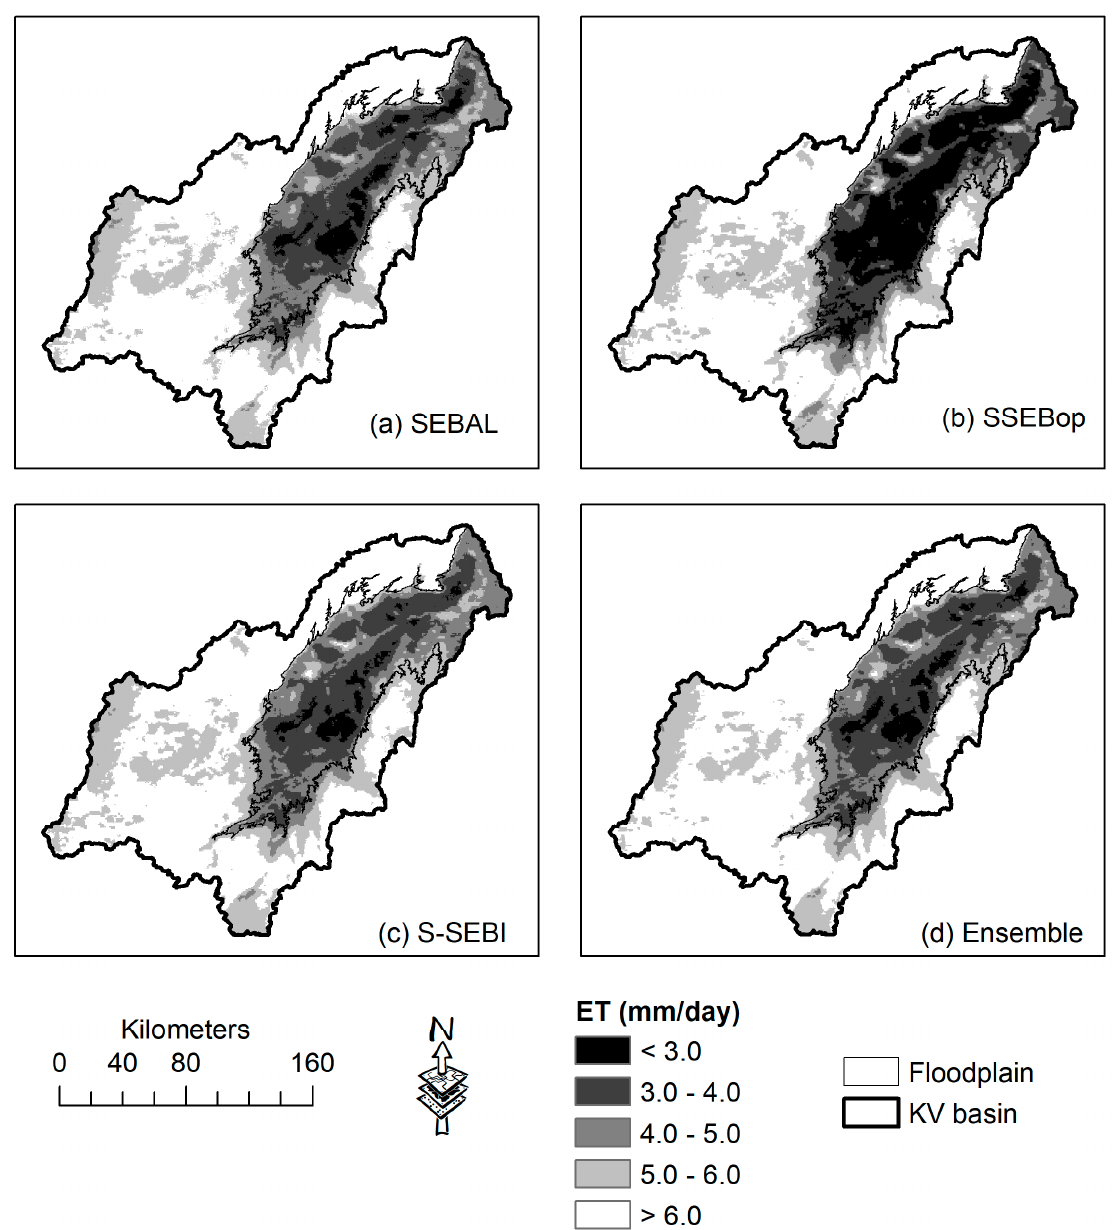
Figure 4. The long term mean daily actual daily evapotranspiration (ET) in the Kilombero Valley (KV) river basin for the 25 MODIS satellite overpasses. ( a ) the actual ET derived by the SEBAL model, ( b ) the actual ET derived by the SSEBop model, ( c ) the actual ET derived by the S-SEBI model, and ( d ) the actual ET derived by the ensemble mean of all 3 Models.